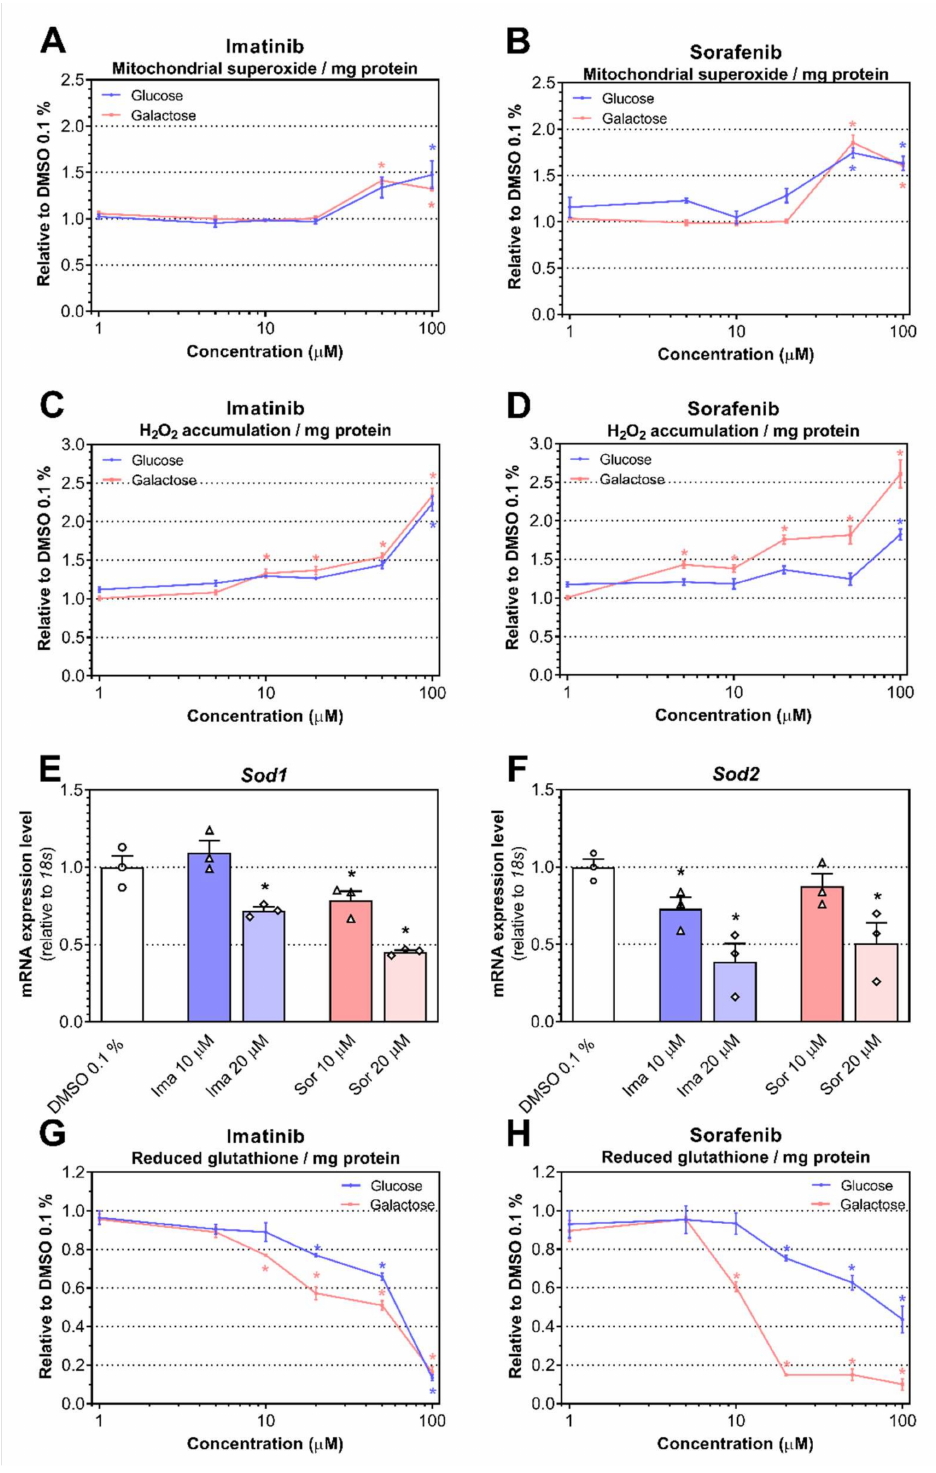
Figure 4. Effects of imatinib and sorafenib on redox status. ( A , B ) Mitochondrial superoxide content after 24 h exposure to imatinib ( A ) and sorafenib ( B ) under glucose and galactose media. ( C , D ) Cellu- lar H 2 O 2 content after 24 h exposure to imatinib ( C ) and sorafenib ( D ) under glucose and galactose media. ( E , F ) Relative mRNA expression of Sod1 ( E ) and Sod2 ( F ) of cells exposed to imatinib (Ima) and sorafenib (Sor) under glucose media. ( G , H ) GSH content after 24 h exposed to imatinib ( E ) and sorafenib ( F ) under glucose and galactose media. Data represent the mean ± SEM of at least four independent experiments. * P < 0.05 versus 0.1% DMSO